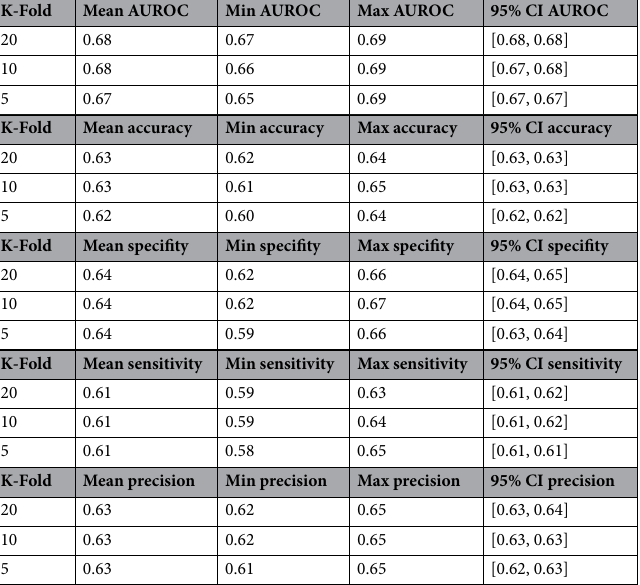
Table 1. Results from the PLS-DA analysis of spectrum region of 1800–900 cm −1 . Averaged results from the PLS-DA model k-fold cross-validation predictive ability repeated 100 times with k-fold values 20, 10 and 5. For each mean AUROC value the P-value was P < 0.001, and the P-values were calculated by using test 1 according to Ojala and Garriga 22 . The number of latent variables were set to 32 for k-folds 20 and 10, but for k-fold 5 the latent variables were set to 31, as it was yielding the best performance in predictive ability. There were 558 negative and 558 positive nasopharyngeal swab samples (dissolved into the viral transport medium and inactivated by adding viral lysis buffer liquid) measured with ATR-FTIR spectroscopy. Every sample was measured three times. The measured samples were preprocessed before PLS-DA, by applying spectrum truncation to the spectrum region of 1800–900 cm −1 , vector normalization and spectrum averaging to create a one average spectrum for every measured nasopharyngeal swab